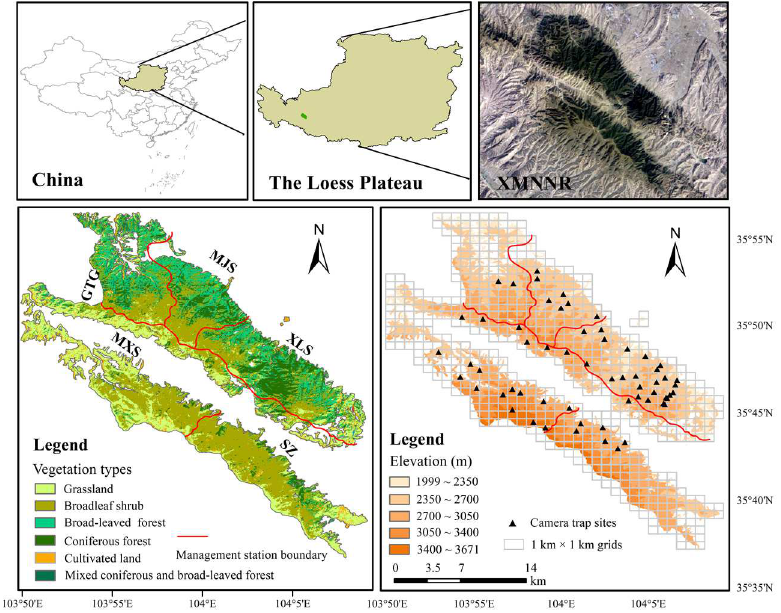
Figure 1. The camera trap sites in the study area and land use types. GTG—Guantangou, MJS— Majiasi, XLS—Xinglongshan, MXS—Maxianshan, and SZ—Shangzhuang.